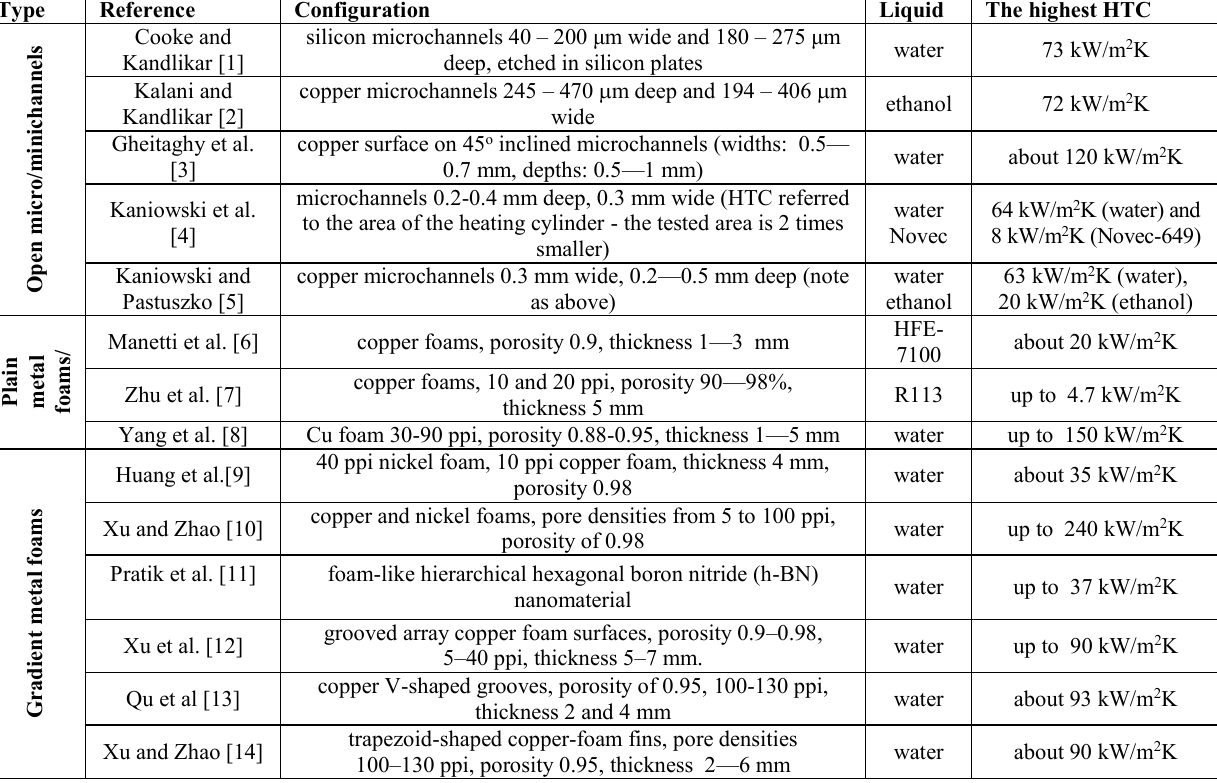
Table 1. Types of structures with micro, minichannels and metal foams for pool boiling enhanced heat